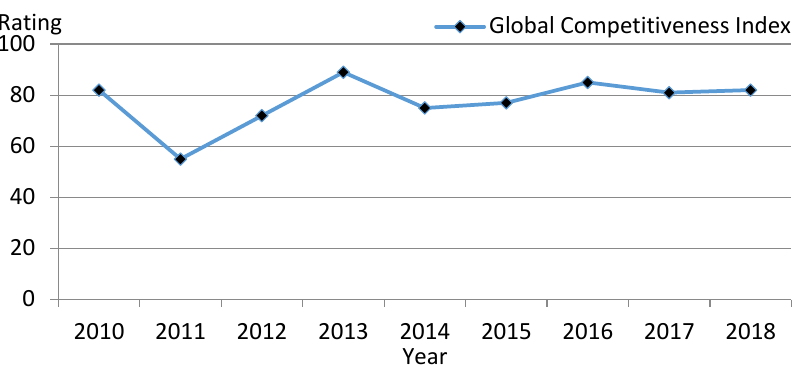
Fig. 7: The Global Competitiveness Index of Ukraine (WEF, 2019)